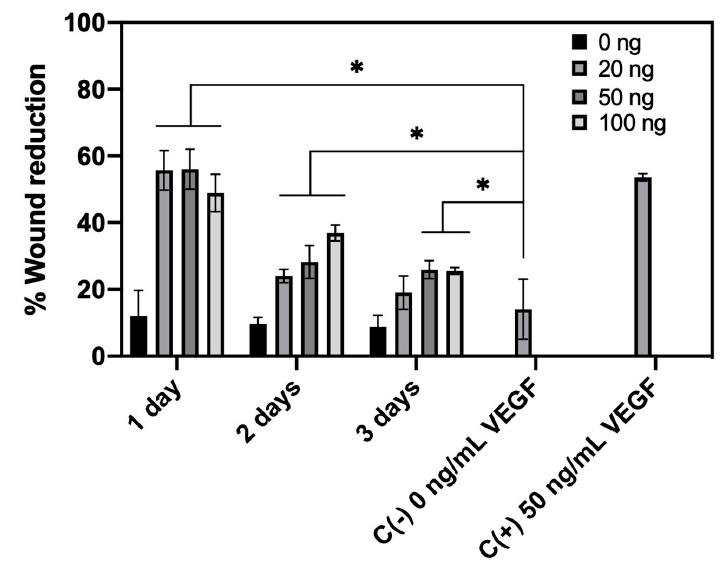
Figure 10. Quantitative analysis of the pro-migration e ff ect of released VEGF expressed as a relative percentage of the wound gap reduction on a HUVEC monolayer after 24 h (* p < 0.05). The test was repeated twice and each in duplicate ( n = 4).